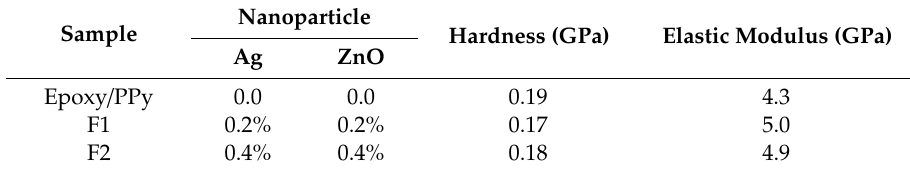
Table 4. Micro-hardness and reduced modulus recorded for the fabricated epoxy coatings (F1 and F2) containing Ag and ZnO nanoparticles.